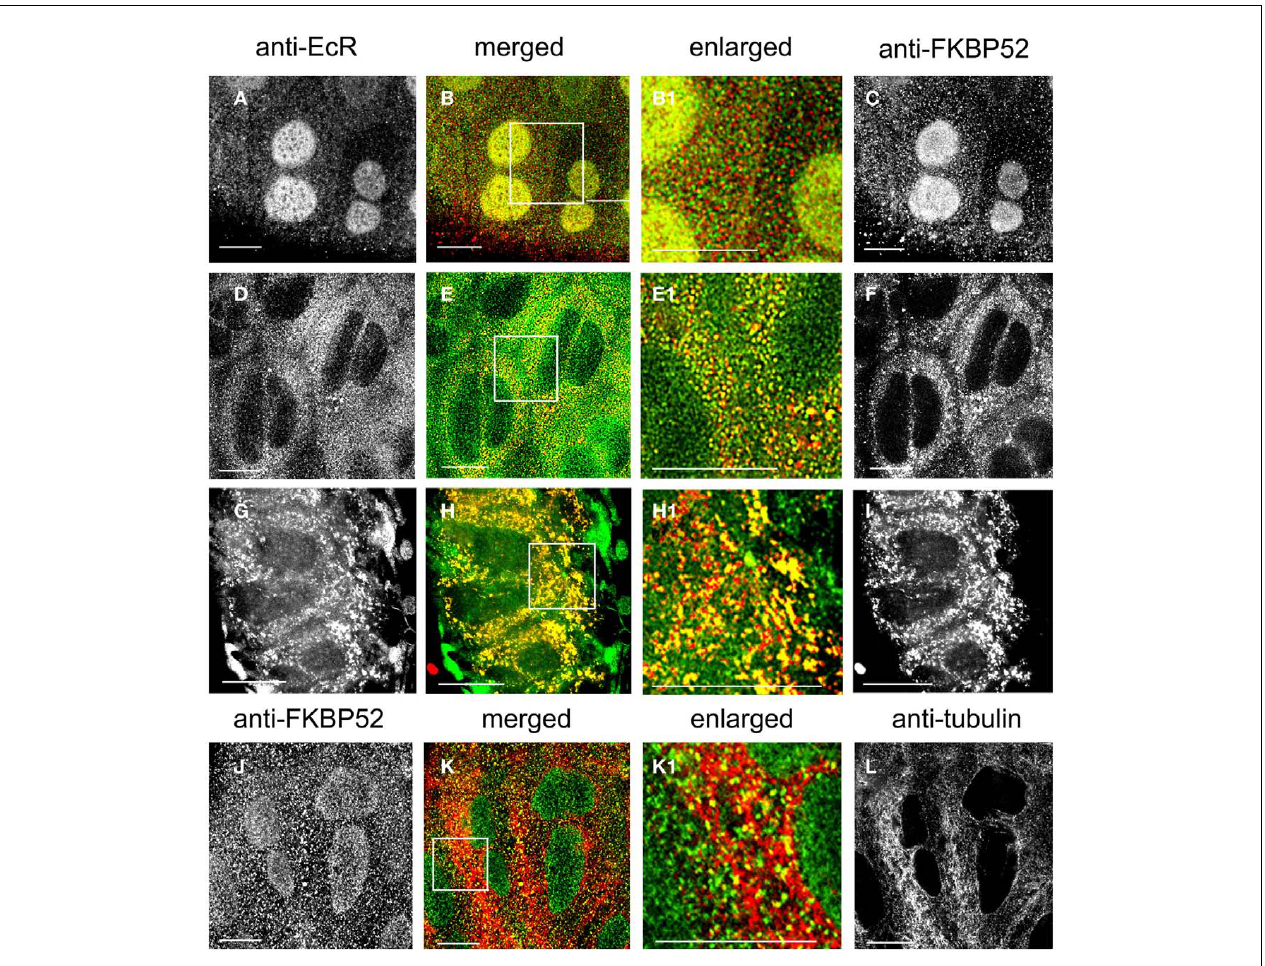
(A–C) Show scotophase and (D–F) show photophase. Note the absence of cytoplasmic co-localization of EcR fluorescence and FKBP52 fluorescence in scotophase and its presence in nuclei [red and green specks in (B1) ]. In contrast, note extensive co-localization in the cytoplasm in photophase and its absence from nuclei [yellow specks in (E1) ]. (G–I) Show cells pre-treated with taxol. Note the alignment of yellow dots and rods in lines in (H1) . In (K1) , note co-localization of FKBP52 fluorescence with anti-tubulin (yellow specks along MTs). Scale bars = 10 μ